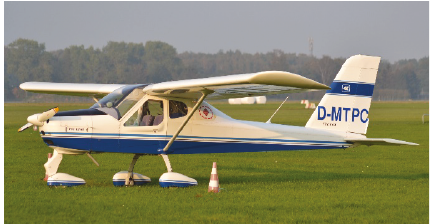
Figure 1: Semiautonomous P92